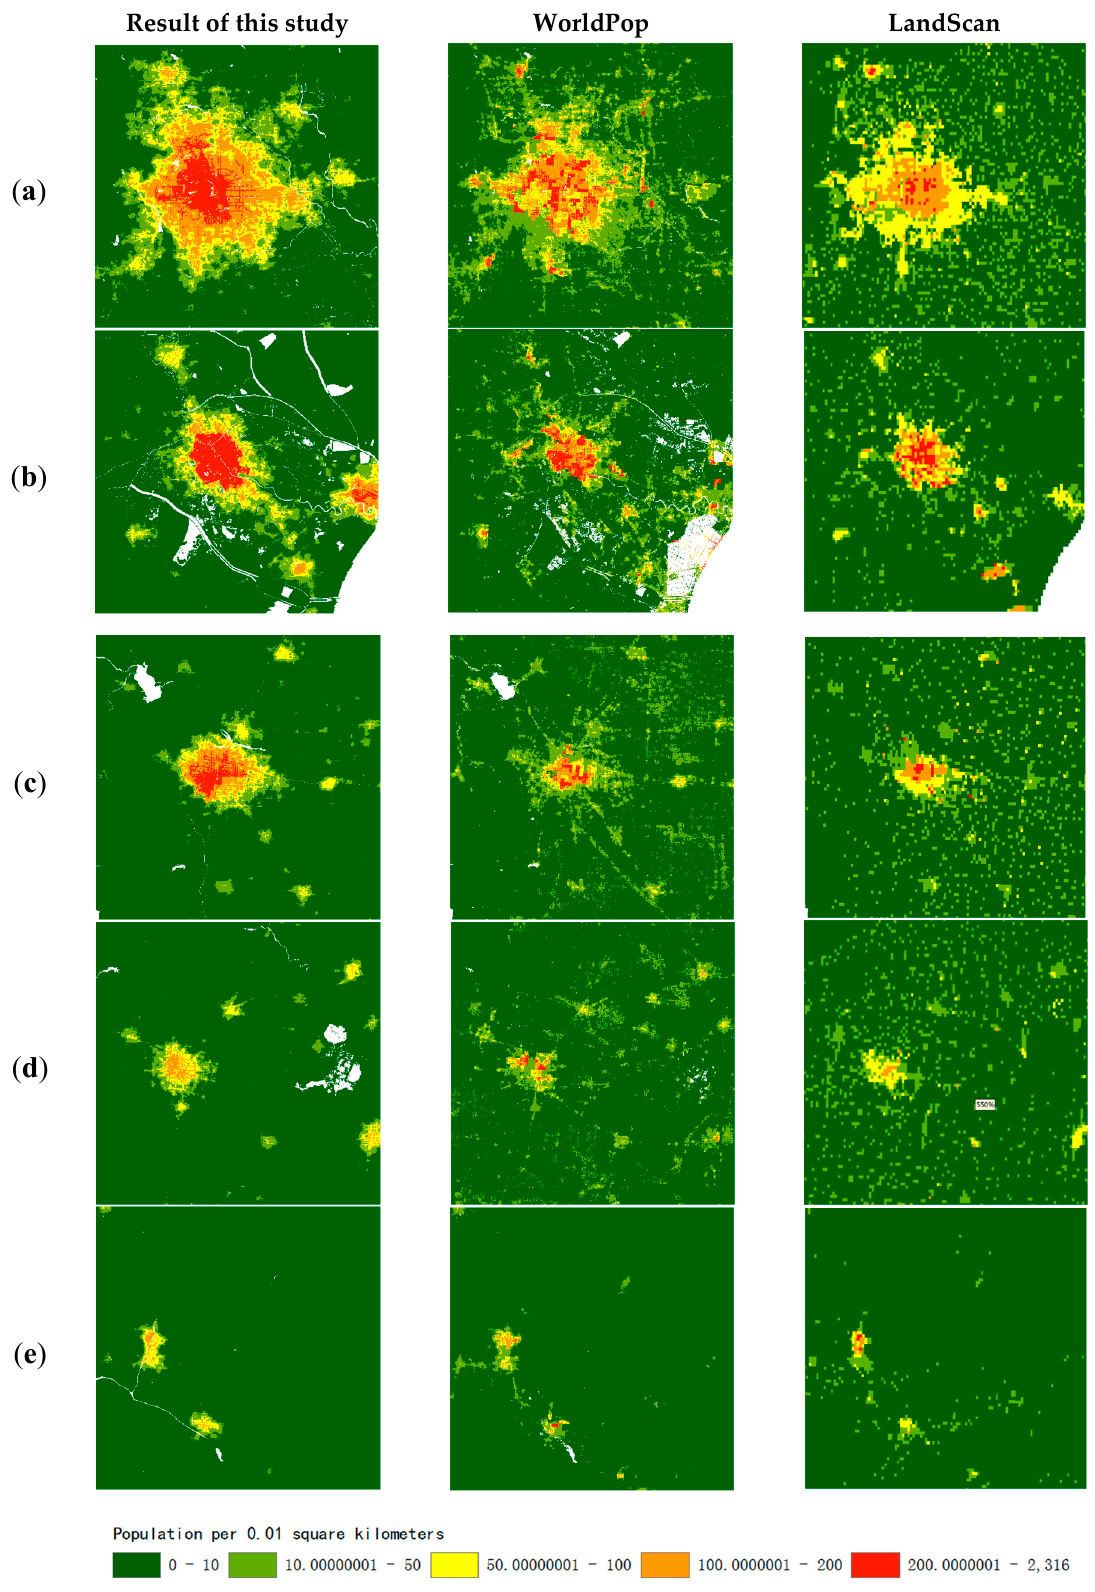
Figure 7. Comparison of different datasets in typical areas. ( a ) Beijing, ( b ) Tianjin, ( c ) Shijiazhuang, ( d ) Baoding, and ( e ) Zhangjiakou.